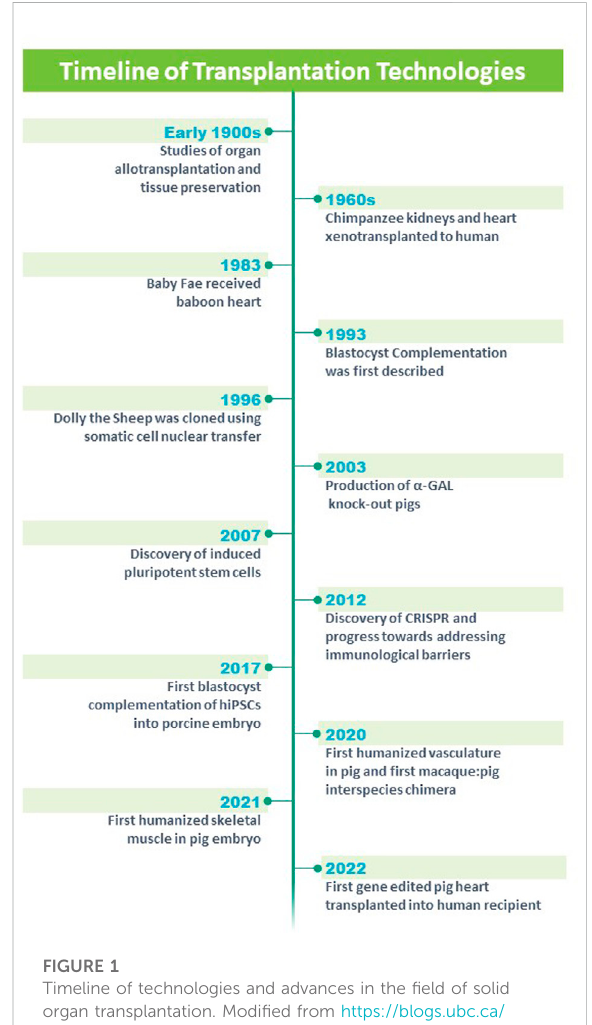
FIGURE 1 Timeline of technologies and advances in the fi eld of solid organ transplantation. Modi fi ed from https://blogs.ubc.ca/